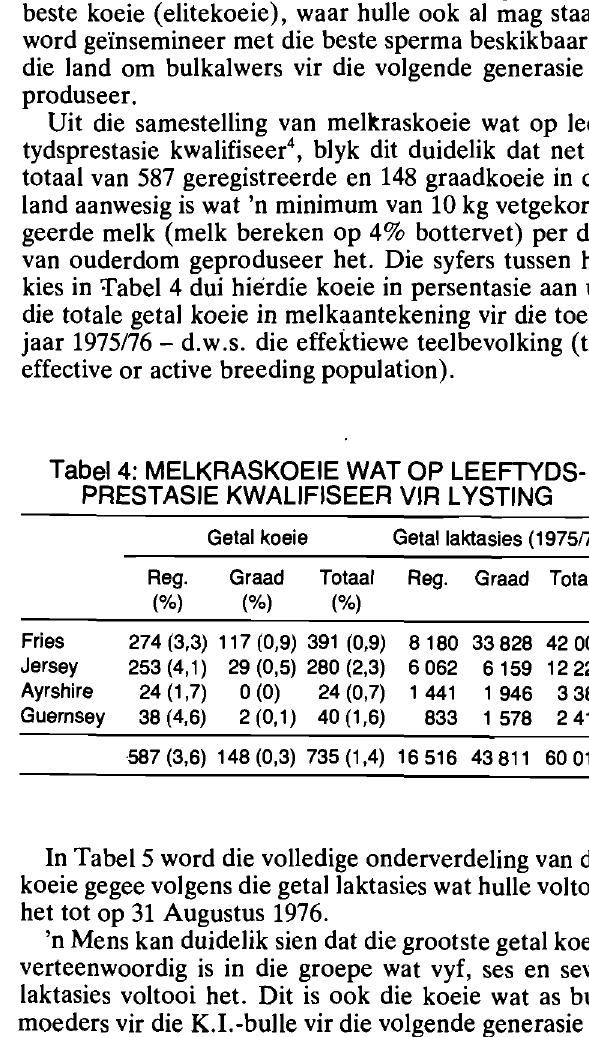
Tabel 6 word hierdie groepe vir die geregistreerde